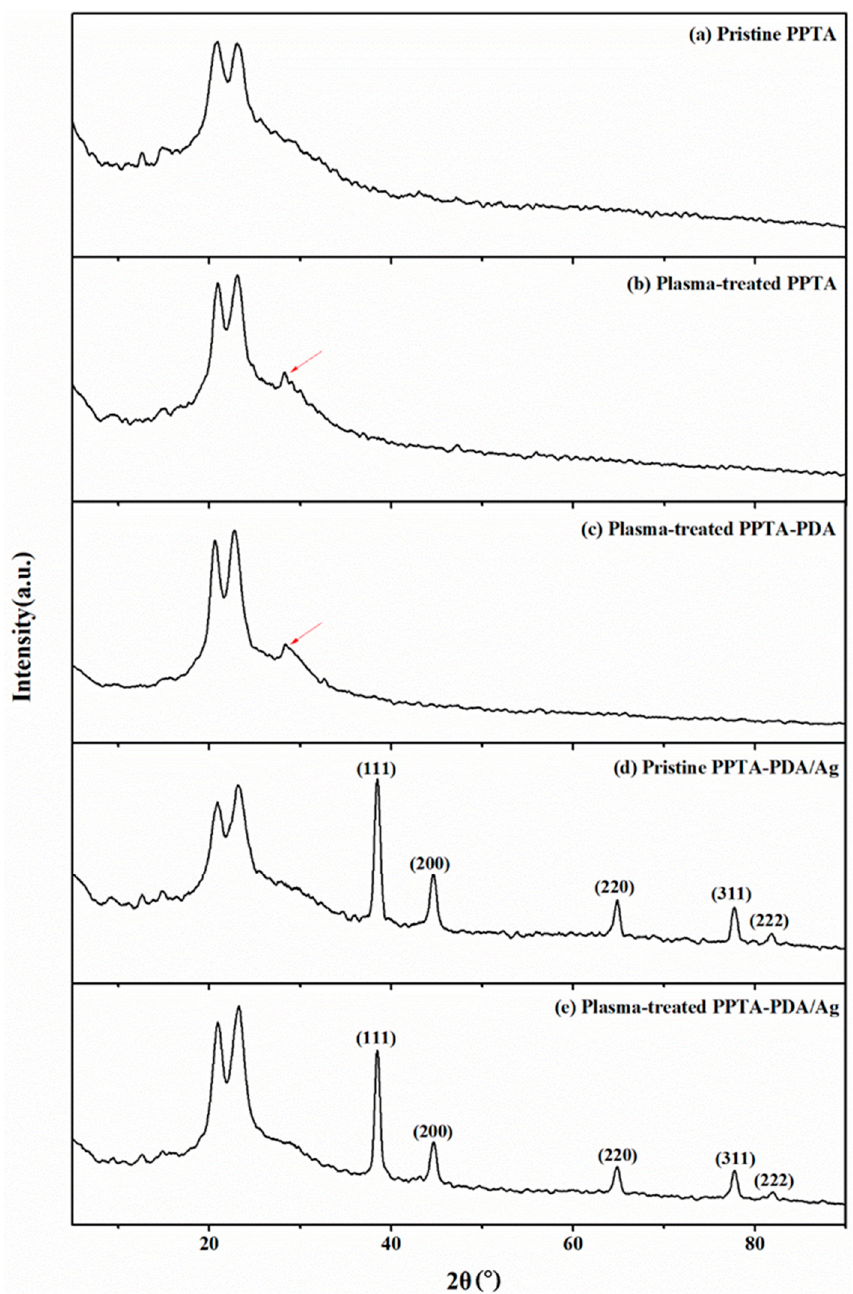
Figure 5. X-ray diffraction patterns of ( a ) pristine PPTA fibers, ( b ) plasma-treated PPTA fibers, ( c ) plasma-treated PPTA-PDA fibers, ( d ) pristine PPTA-PDA/Ag fibers and ( e ) plasma-treated PPTA-PDA/Ag fibers.